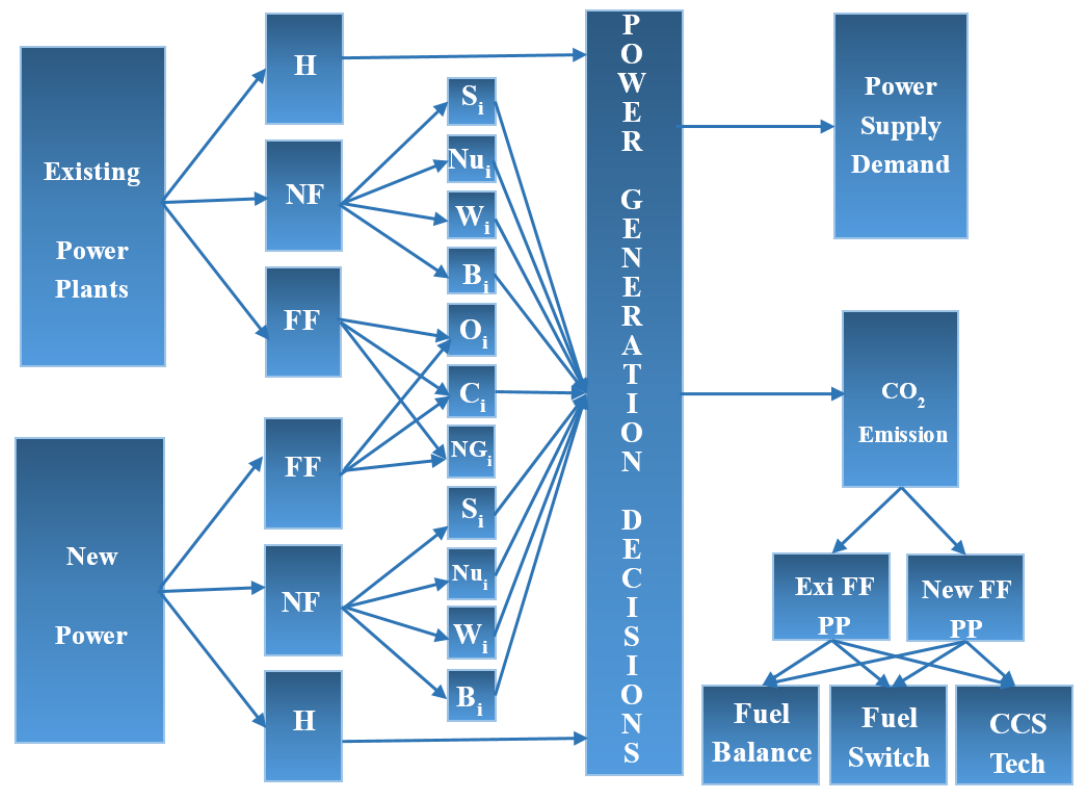
Figure 6. Superstructure representation for the optimization of the power sector.